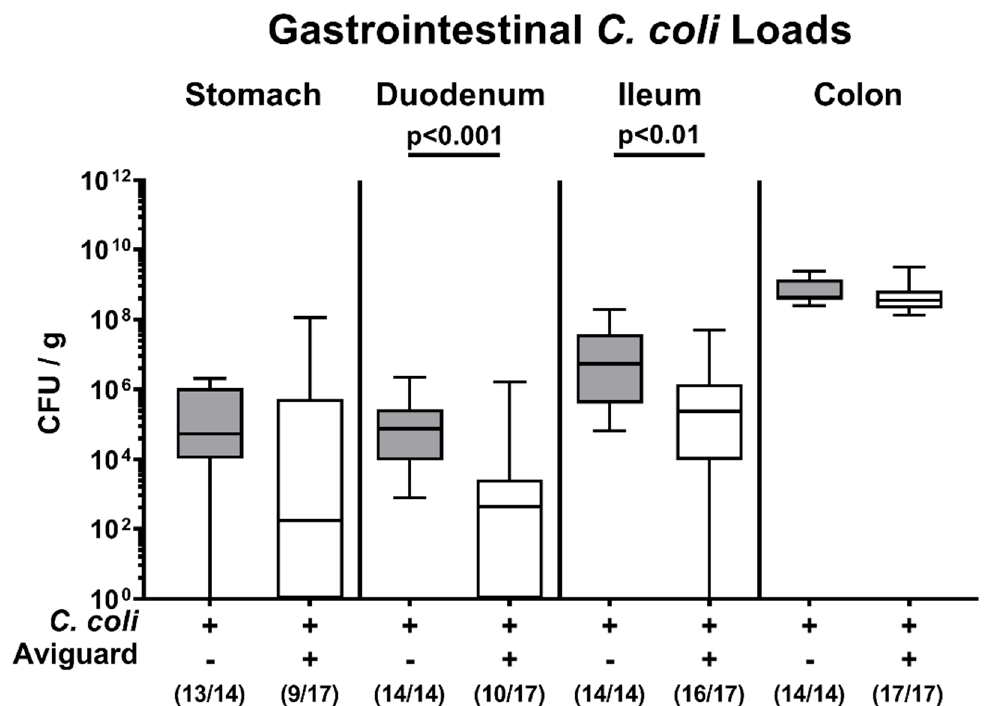
Figure 2. Gastrointestinal pathogen loads following peroral treatment of C. coli -infected secondary abiotic IL-10 − / − mice with the probiotic formulation Aviguard ® . Mice were infected with a C. coli patient isolate on day (d) 0 and d1 by gavage. On d2, d3 and d4 post-infection (p.i.), mice were perorally challenged with the commercial competitive exclusion product Aviguard ® (white boxes) or received placebo (gray boxes). On d6 p.i., the pathogen loads were quantitatively assessed in distinct compartments of the gastrointestinal tract (indicated) by culture (in colony-forming units per g, CFU / g). The box plots indicate the 25th and 75th percentiles of the medians (bar within boxes). The total range, the significance levels ( p values) calculated by the Mann–Whitney U test and the numbers of culture-positive mice out of the total number of analyzed animals (in parentheses) are given. Pooled data were derived from three independent experiments. +, with; − , with- out.